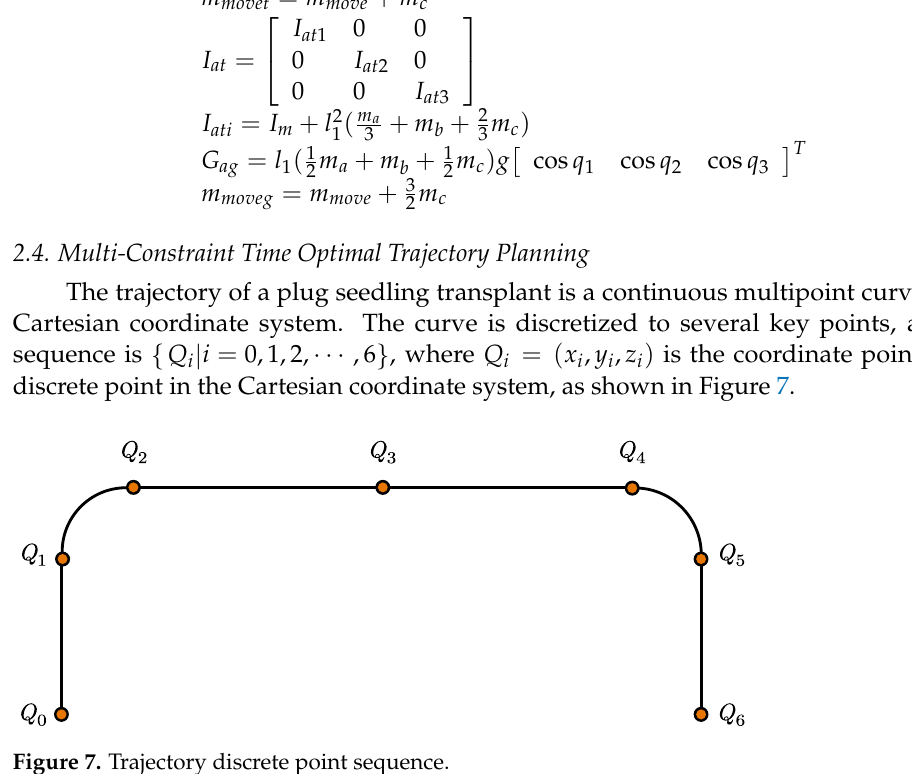
Q is the placement point. 6